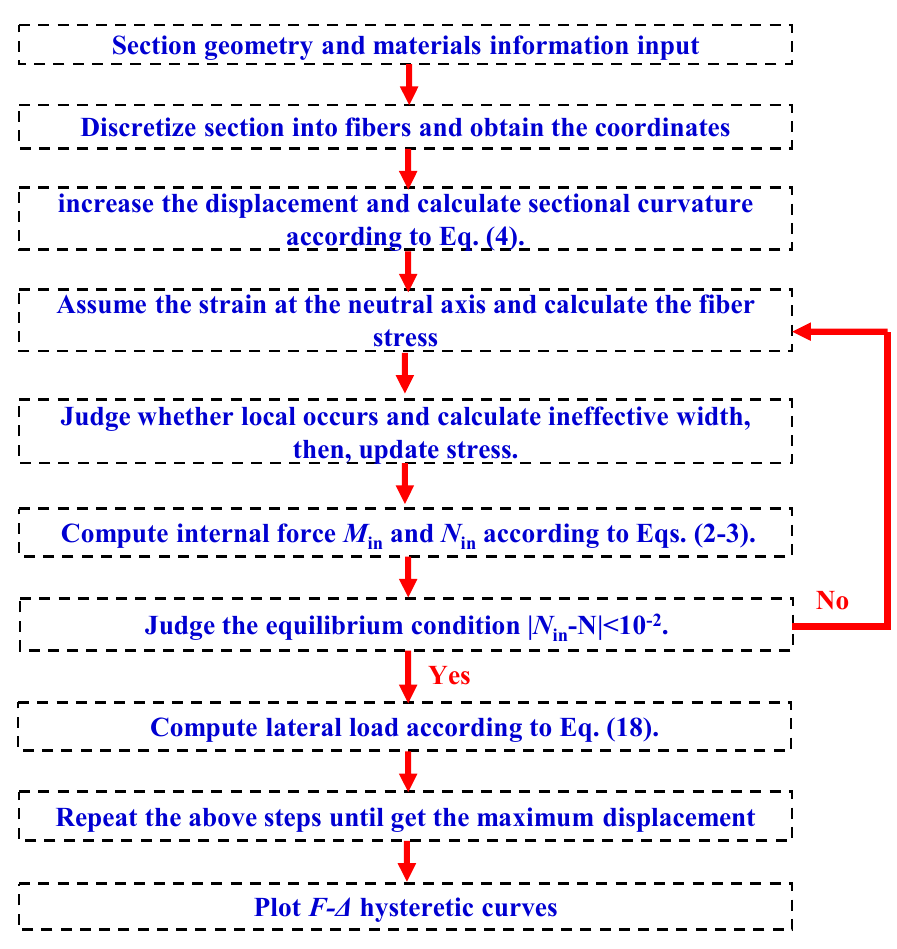
Figure 6. The fl owchart of the hysteresis curve calculation. Figure 6. The flowchart of the hysteresis curve calculation.